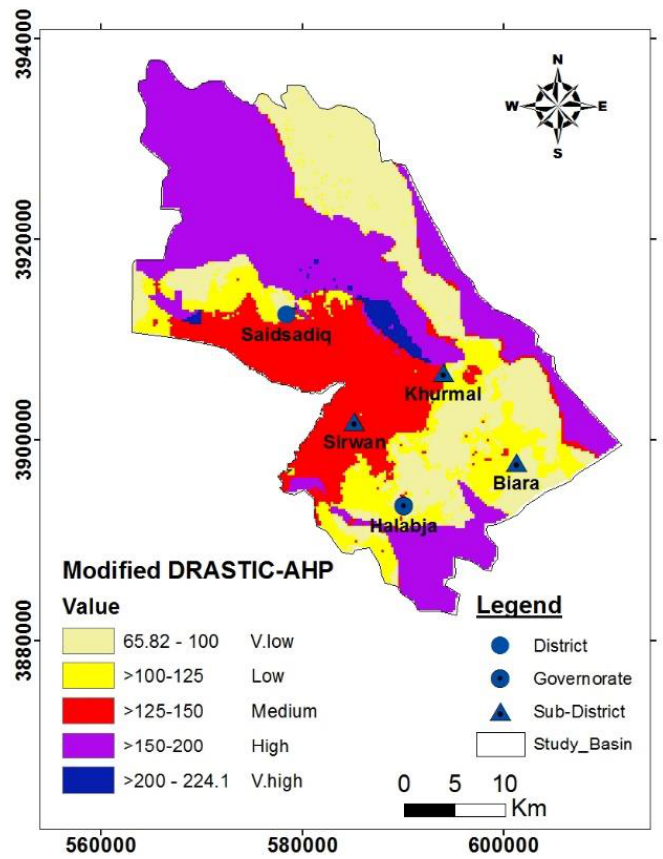
Figure 4. Modified DRASTIC index map using Analytic Hierarchy Process (AHP) method. Table 1. Types of aquifer in the HSB.